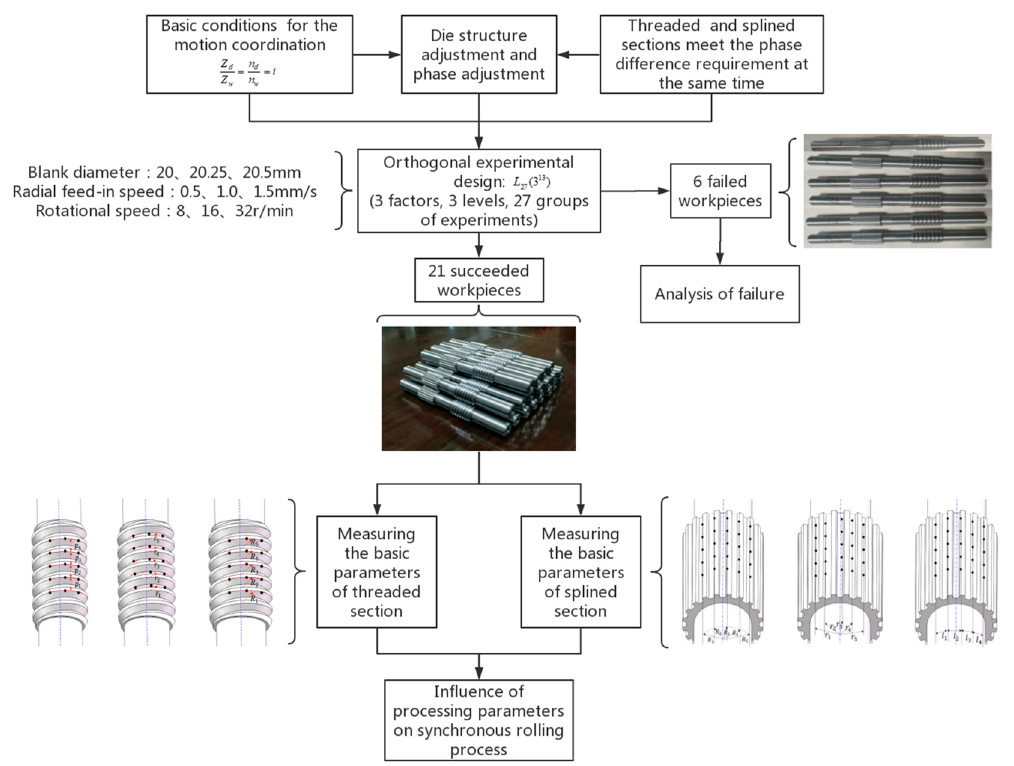
Figure 1. Flowchart of research in the present study.